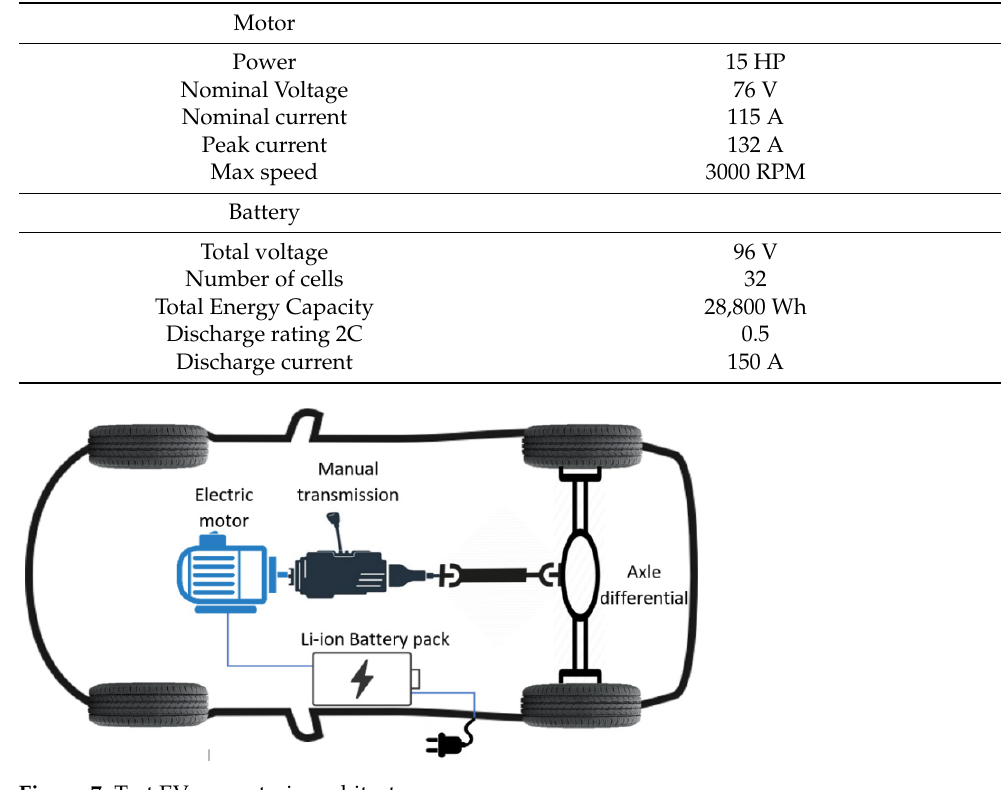
Figure 7. Test EV powertrain architecture. Table 2. Specifications of the test EV’s motor and battery.